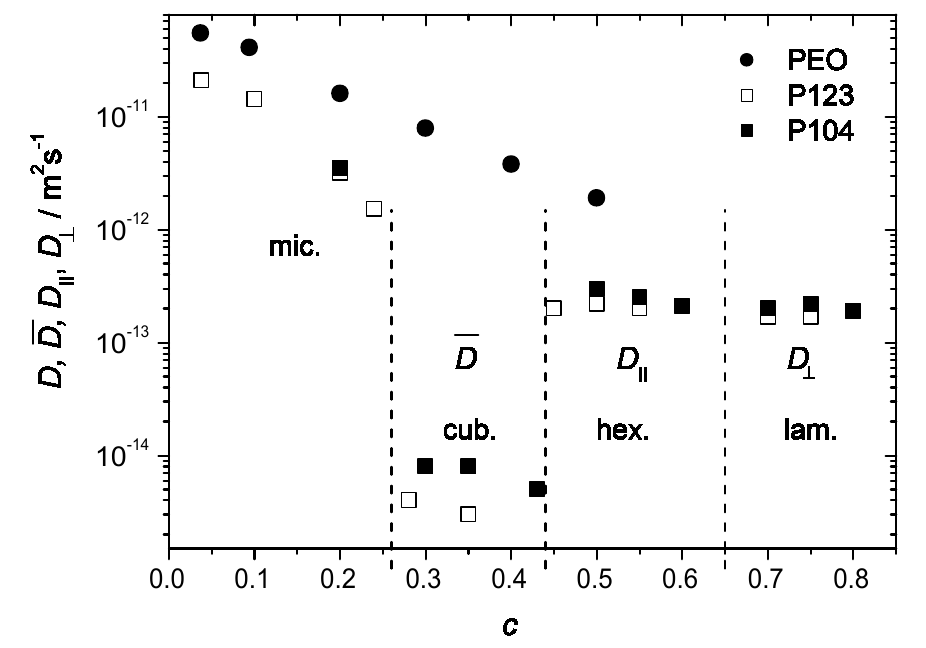
Figure 9. The diffusion coefficients of polymer molecules in the samples P123, P104 and PEO in water as a function of polymer concentration in the broad range from 0 . 1 to 0 . 8 at T = 23 ◦